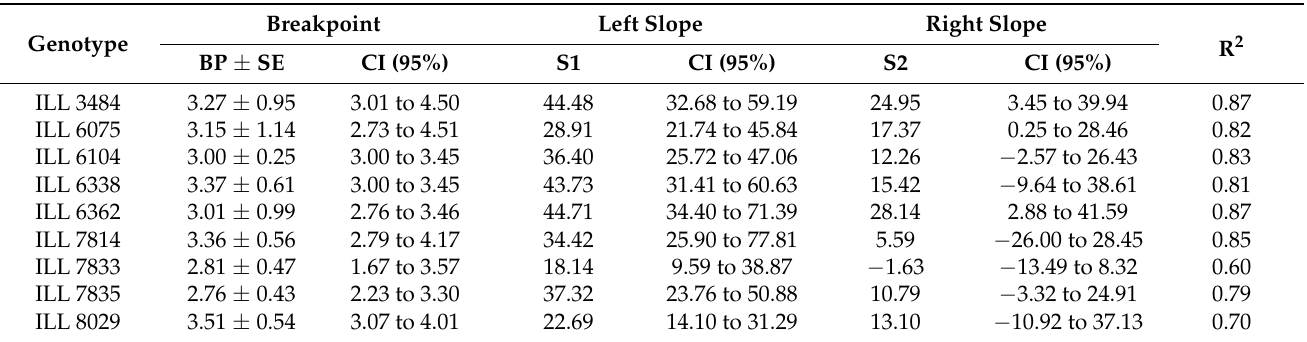
Table 4. Outputs from the analysis of the two-segment linear regression used for fitting the TR to the VPD variations.